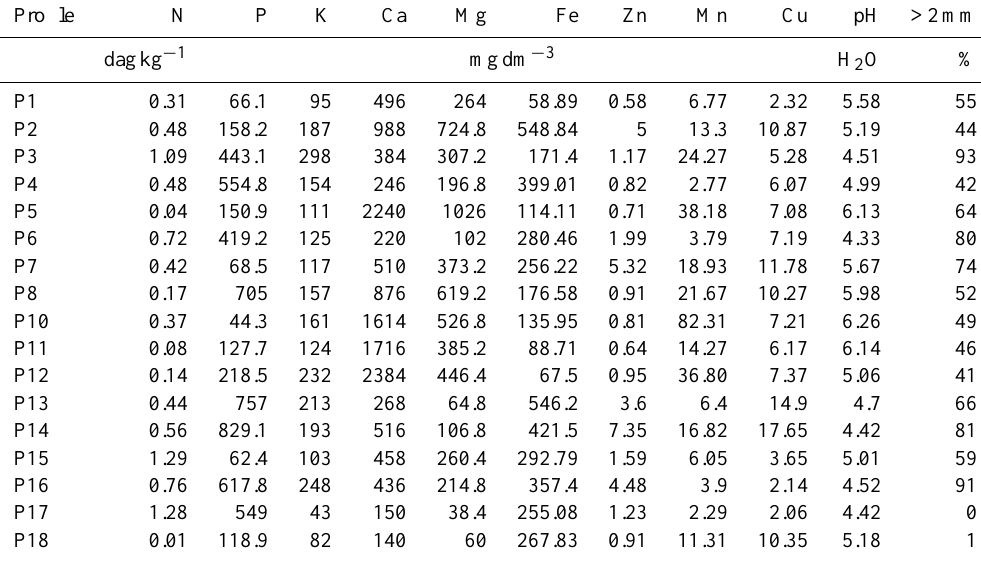
Table 4. Exchangeable nutrient concentration at surface horizons (0–10cm) for the studied soils. Profile